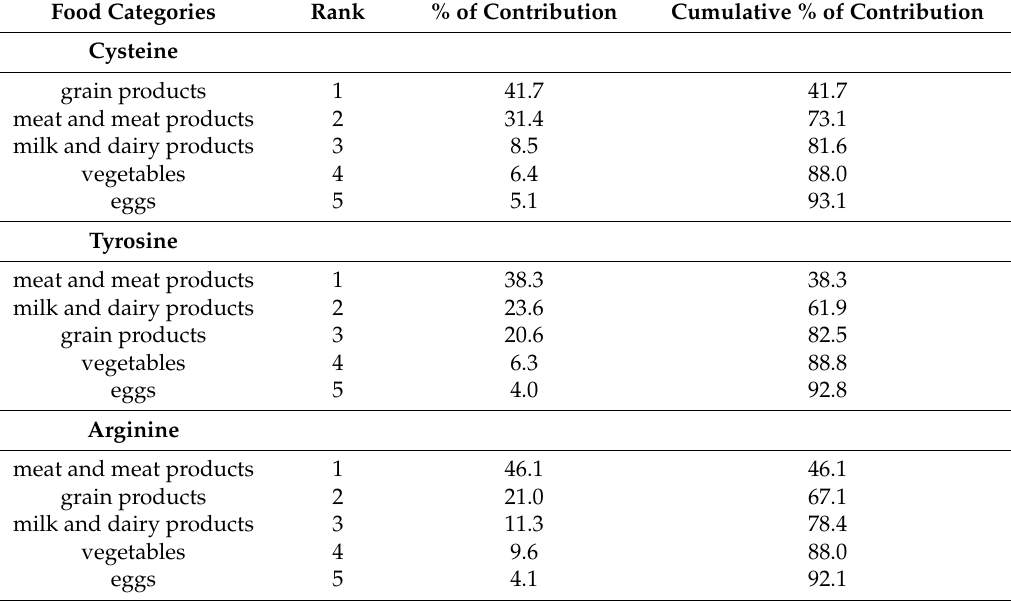
Table 5. Main food category sources of the contribution of cysteine, tyrosine, arginine, proline, and glycine to the average Polish